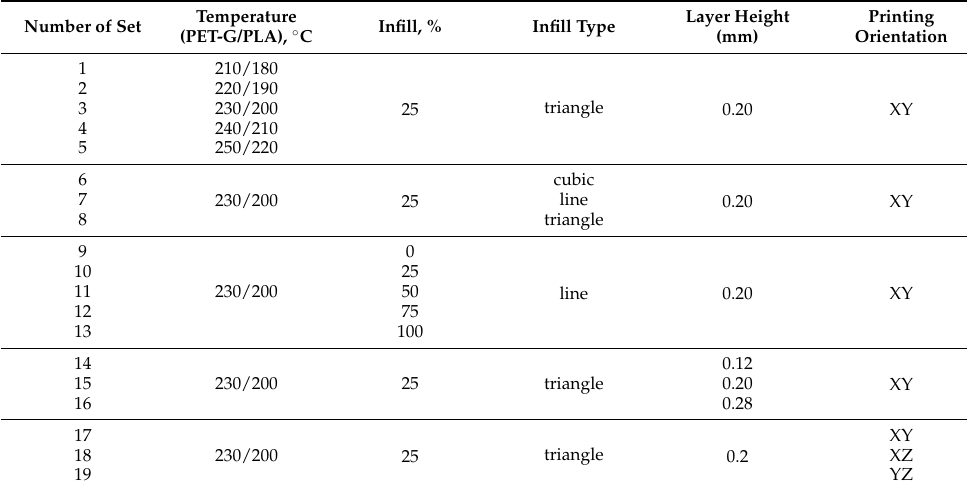
Table 1. Specimens’ manufacturing